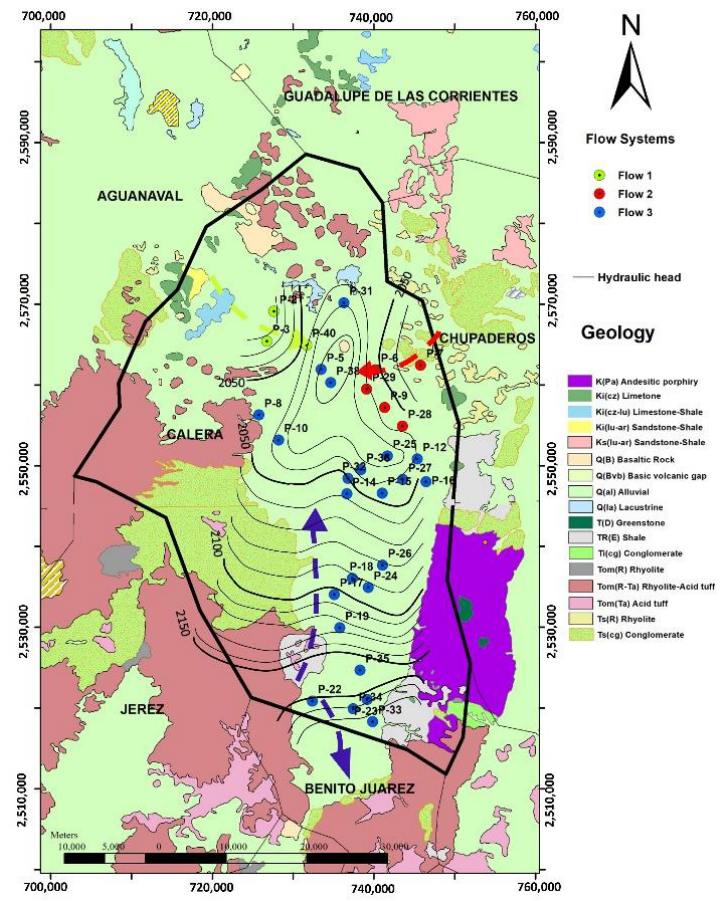
Figure 10. Groundwater flow systems identified within the aquifer using 3D multivariate data (2020).